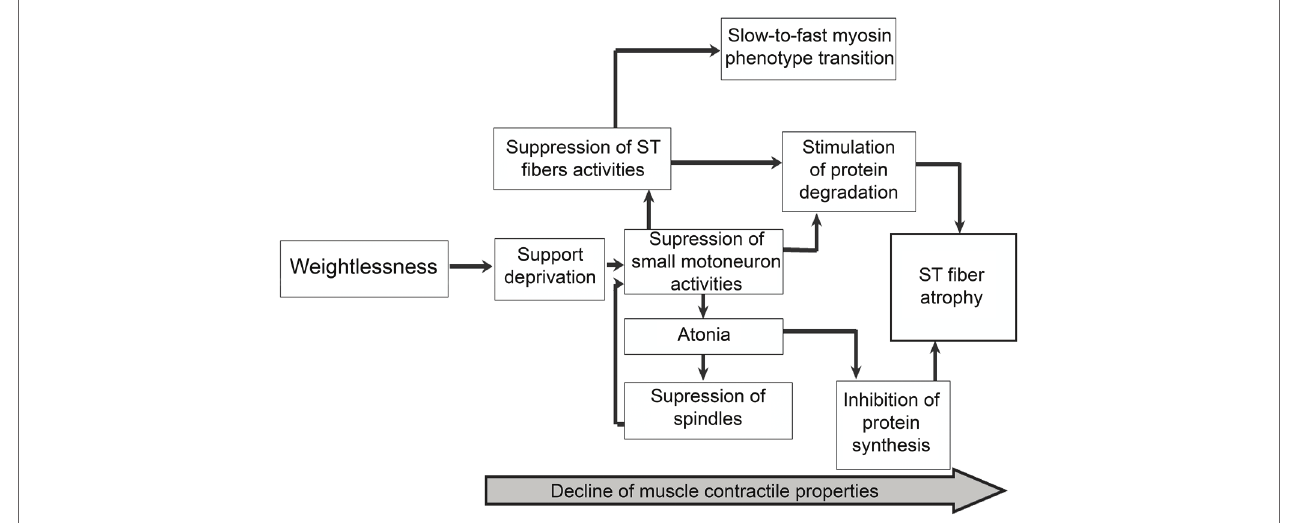
FIGURE 3 | The hypothetical scheme of support withdrawal consequences in postural muscle. The scheme supposes that the exposure to weightlessness leads to the withdrawal of support afferentation. The support withdrawal induces the decline in slow motor unit activity and consequently the decline in mechanical activities of the slow-twitch muscle fibers. This decline means the reduced mechanical reflectory and then intrinsic muscle stiffness. The disuse of slow-twitch muscle fibers leads to reduced protein synthesis and increased protein breakdown, followed by the morphological signs of muscle atrophy. Simultaneously in disused fibers the alteration of myosin heavy chain isoforms expression pattern is followed by the slow-to-fast phenotypic transition.